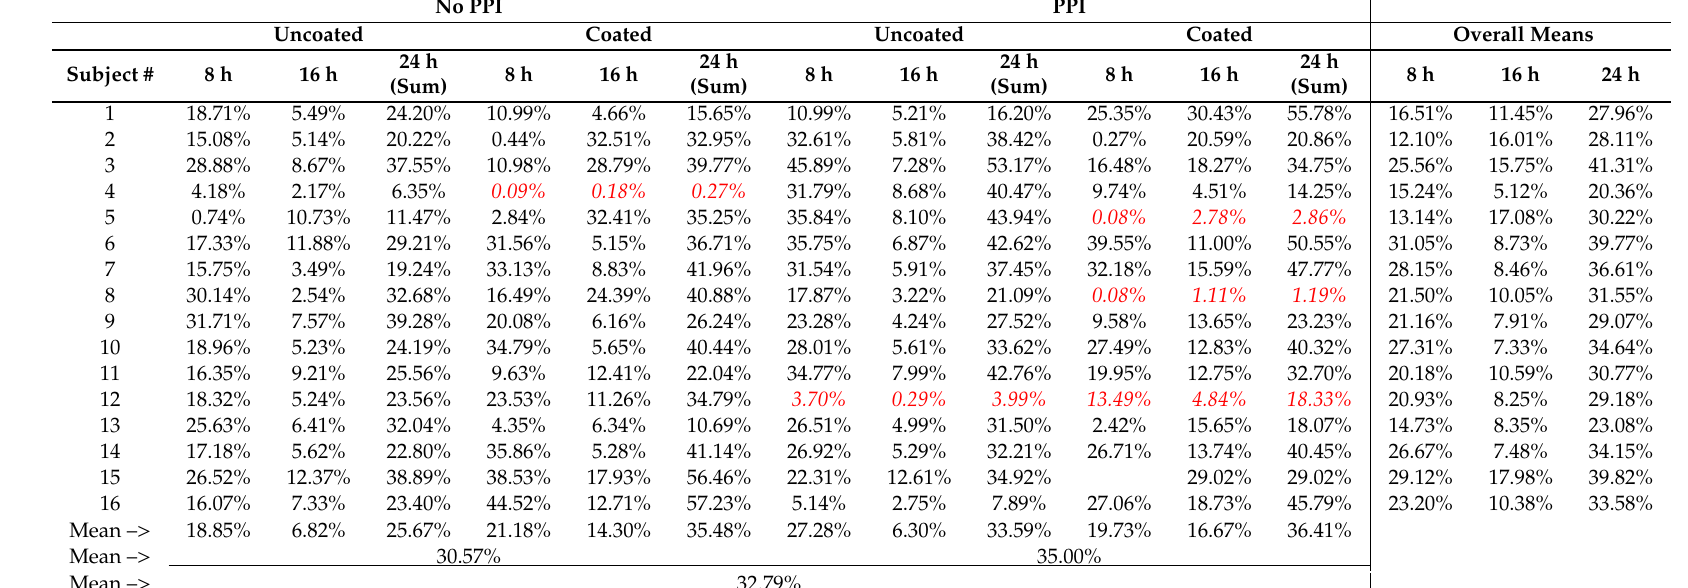
Table 1. PPI Phase conversion e ffi ciency (SF bioavailability) normalized on a molar basis to the dose received. Numbers in red italics were censored from any further treatment of the data (and are not included in column- or row-averages in this table), due to apparent incomplete urine collection or extraordinarily low output as further described in Section